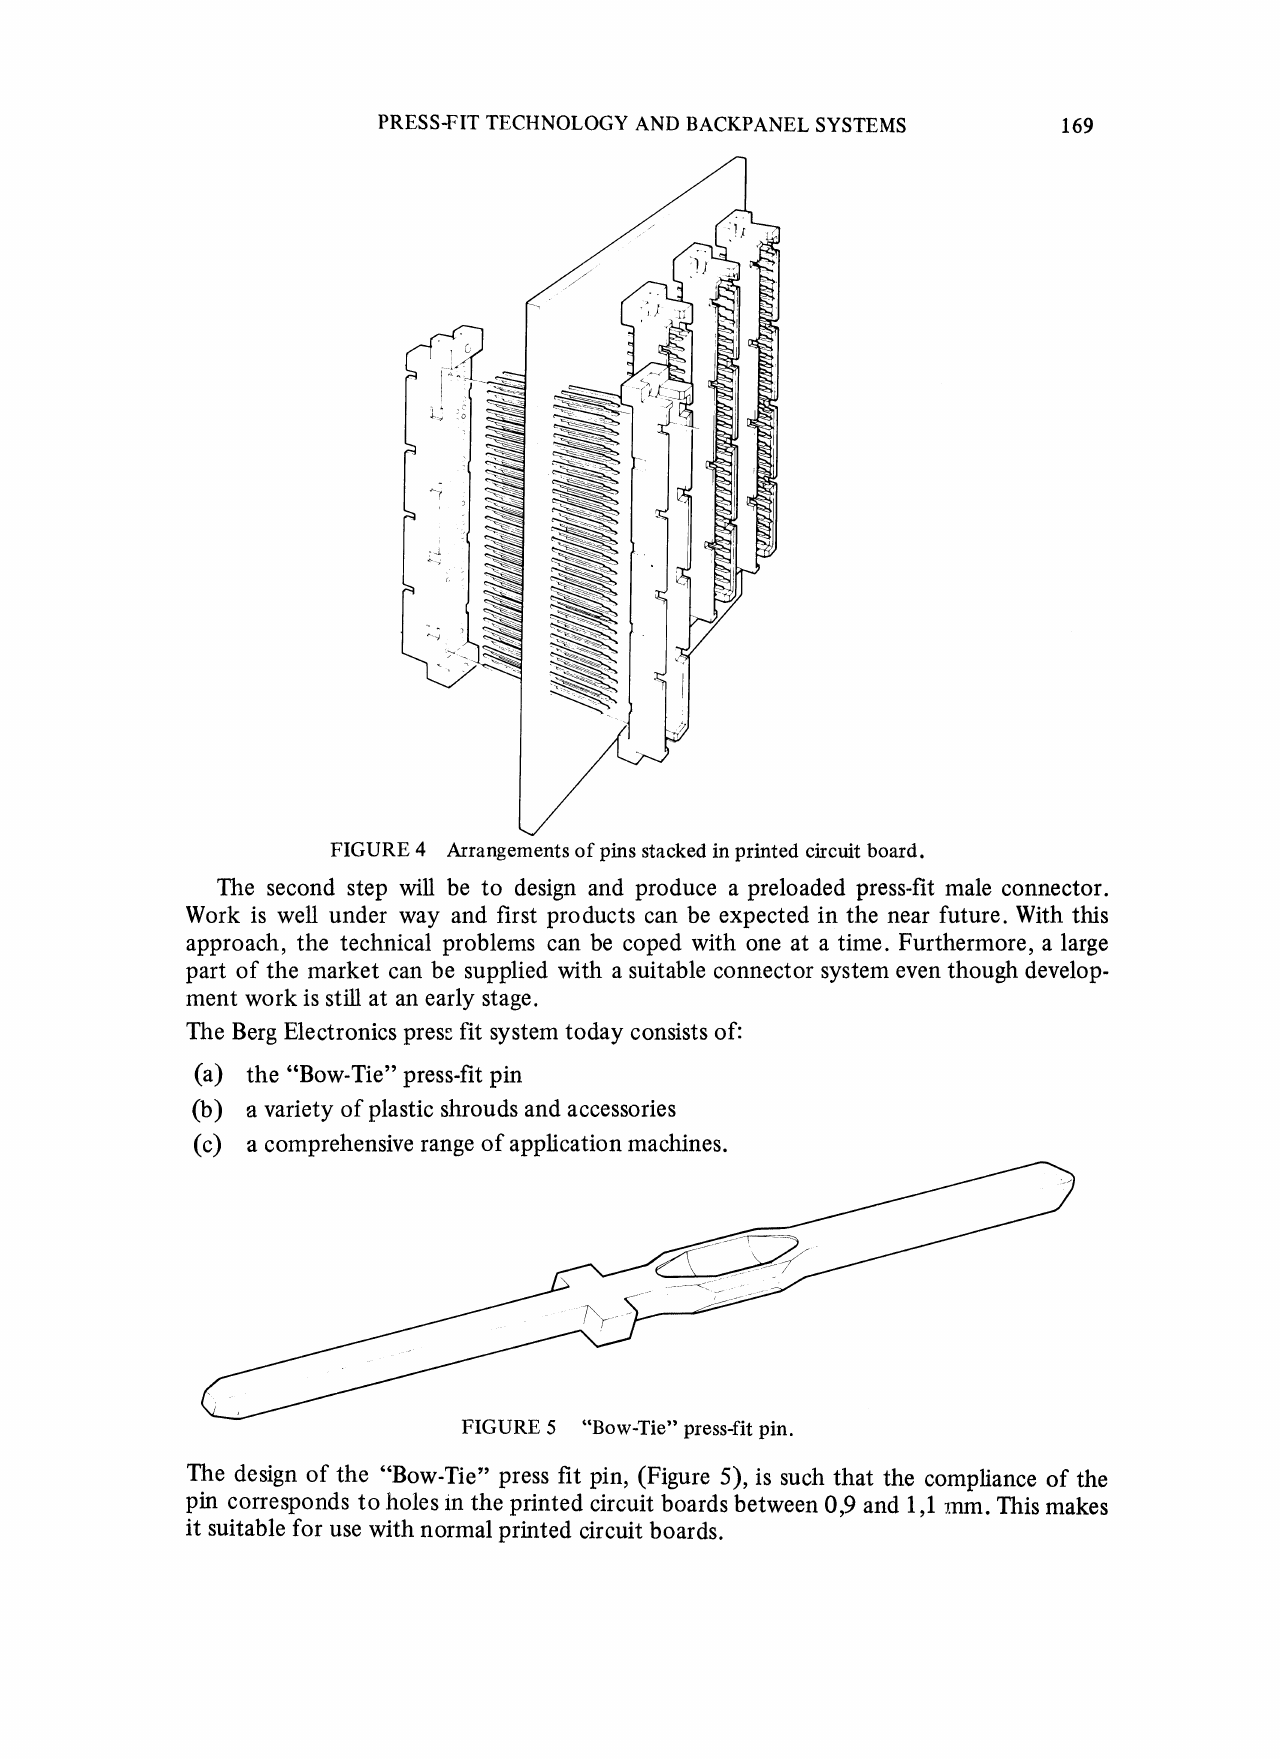
"Bow-Tie" press-fit